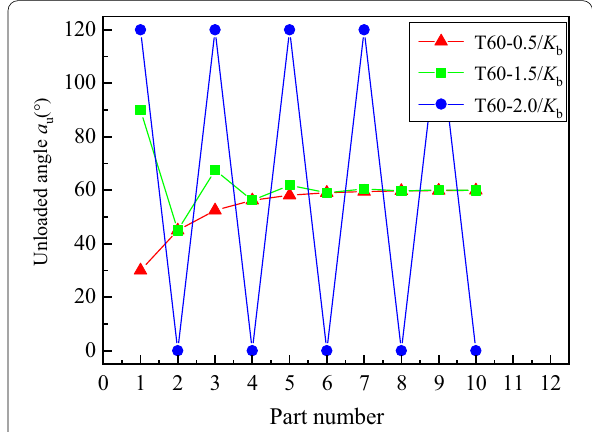
Figure 11 Curves of bending angle after